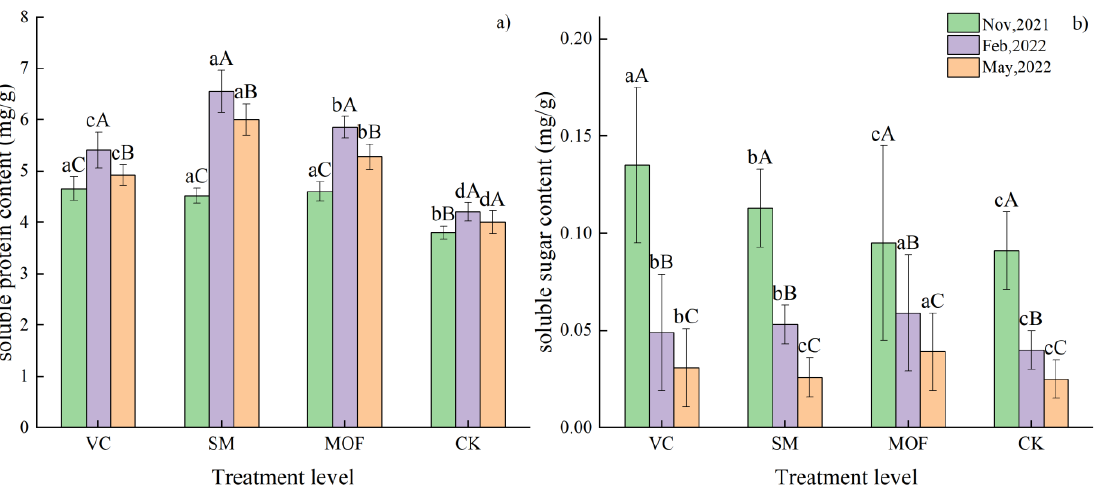
Figure 2. Effects of different bio-organic fertilizer treatments on soluble protein and soluble sugar contents of “Qi-Nan” agarwood seedlings. ( a ) soluble protein content; ( b ) soluble sugar content. No fertilizer (CK); vermicompost (VC); sheep manure (SM); microbial organic fertilizer (MOF). The bars were means ± standard error. Capital letters represent significant differences at the 0.05 level ( p ≤ 0.05) for the same treatment and different periods, and lowercase letters represent significant differences at the 0.05 level ( p ≤ 0.05) for the same period and different treatments.